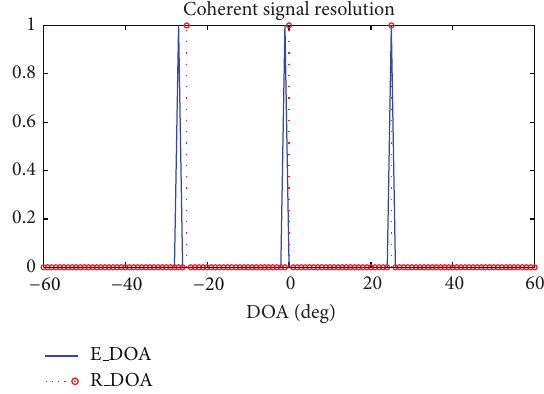
Figure 11: Coherent signal resolution simulation based SVD-SR.